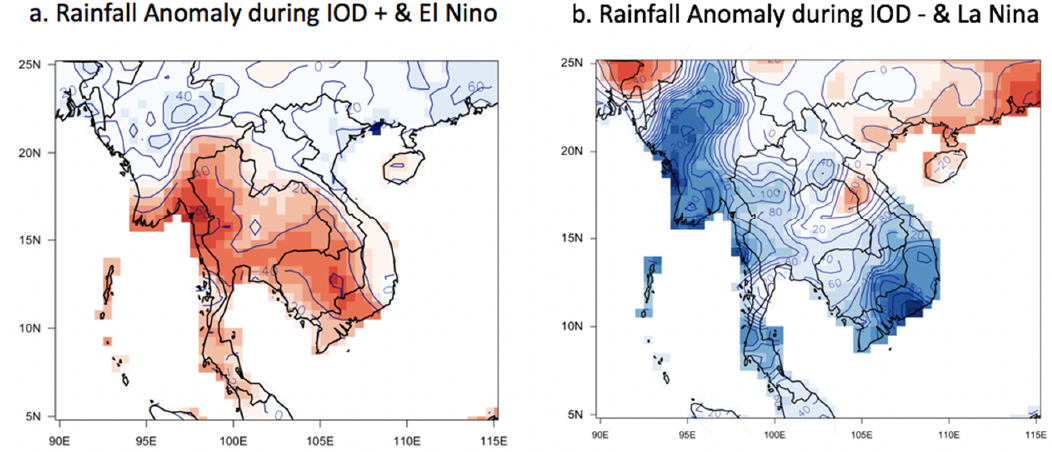
Figure 8. Composite rainfall anomaly in dry season (November–April) associated with the IOD and El Niño–Southern Oscillation (ENSO): ( a ) rainfall anomaly during years with positive IOD and El Niño, and ( b ) rainfall anomaly during years with negative IOD and La Niña. Positive (negative) values show increasing (decreasing) rainfall departure from the long-term average (1981–2010).